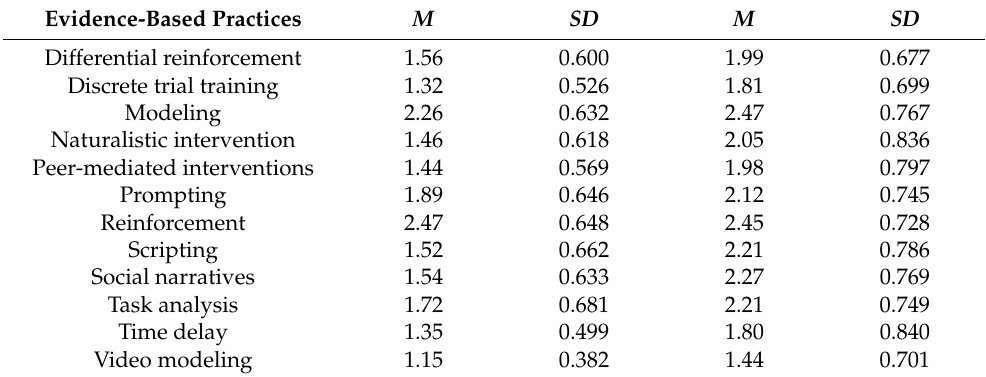
Table 3. Mean Scores ( N = 108) in Teacher Education Programs and In-Service Professional Development.